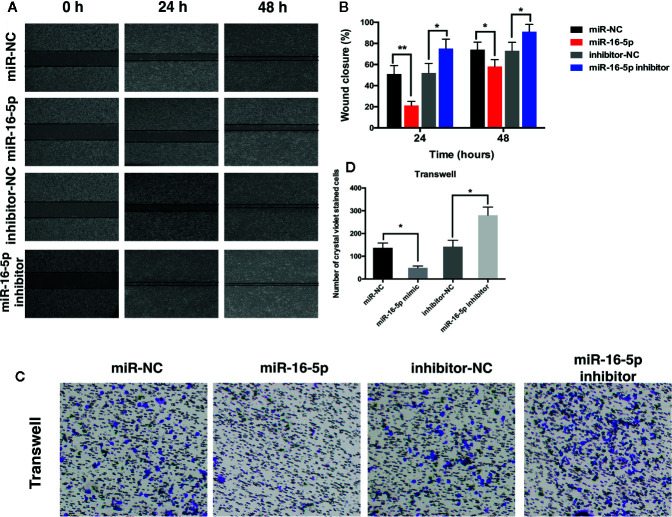
Migration and invasion of osteosarcoma cells were inhibited by miR-16-5p. (A, B) wound-healing assays were performed using MG63 cells transfected with miR-16-5p mimics, miR-NC, miR-16-5p inhibitor, or inhibitor-NC for evaluating cells migration, and percentages of closure at 24 and 48 h were recorded. (C, D) Transwell assays and crystal violet staining were performed to detect the invasive capability of MG63 cells transfected with miR-NC, miR-16-5p mimics, miR-16-5p inhibitor, and inhibitor-NC, and positive stained cells was calculated. *indicates p < 0.05.